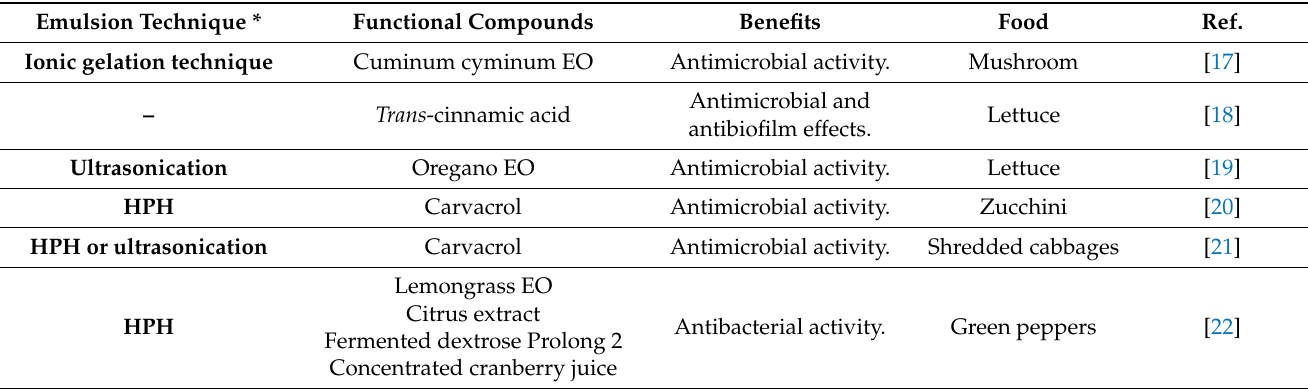
Table 1. Some emulsion systems applied to